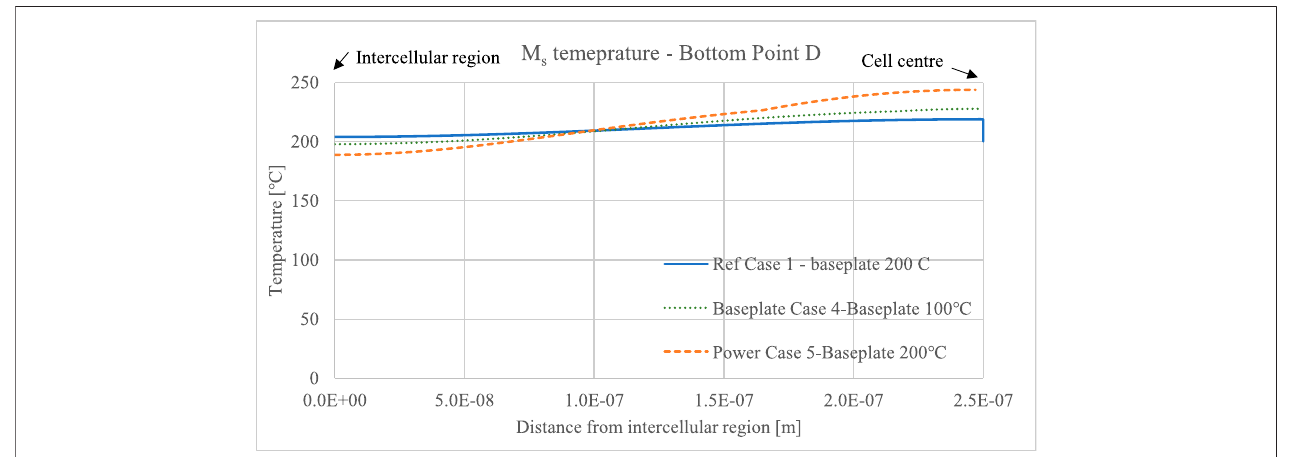
FIGURE 14 | Calculated M s temperature variation for point D as a function of distance from the intercellular region for cases 1, 4, and 5.